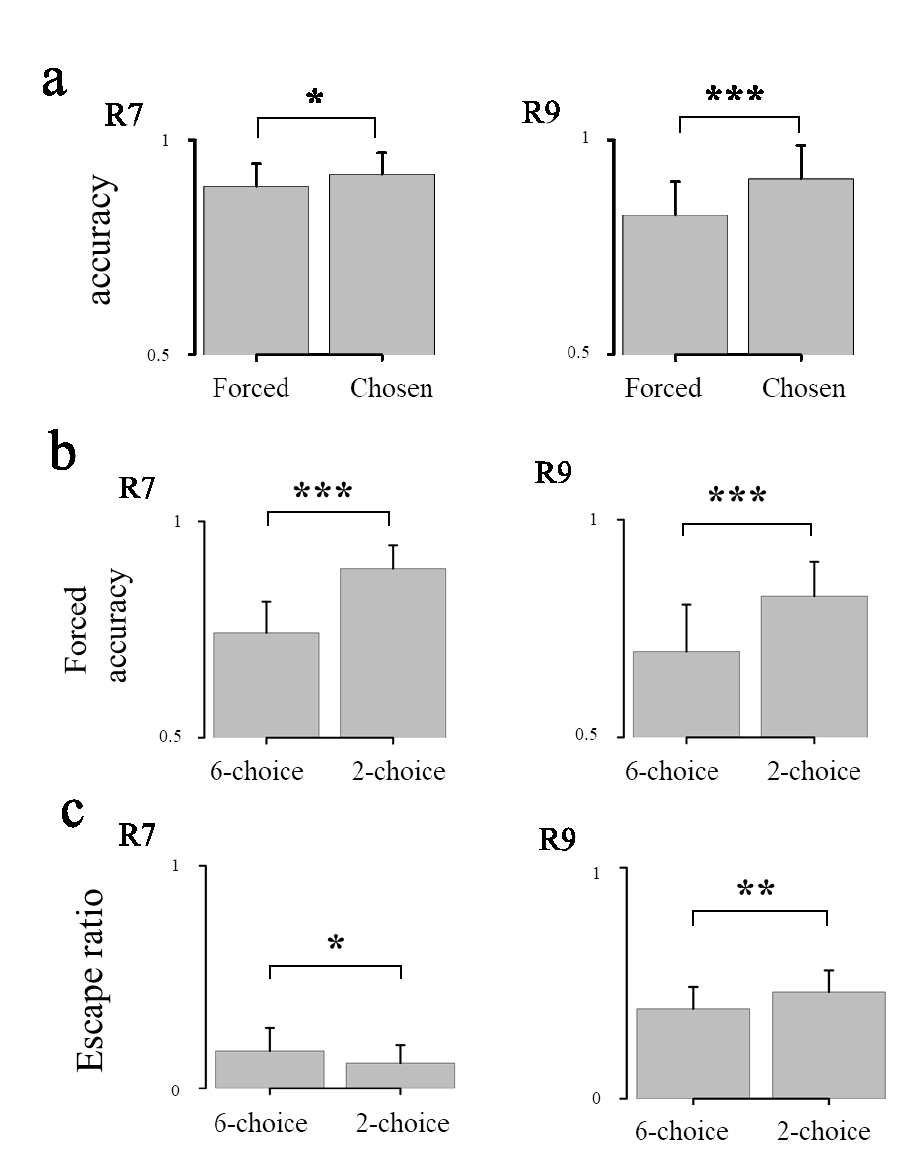
Figure 4 . (a) The difference of accuracies in chosen test trials and those in forced test trials in the two-choice task of R7 and R9. The difference in (b) accuracy or (c) escape ratio in forced test trials between the two-choice and six-choice tasks. * p < .05, ** p < .01, *** p < .001. Error bars represent the standard